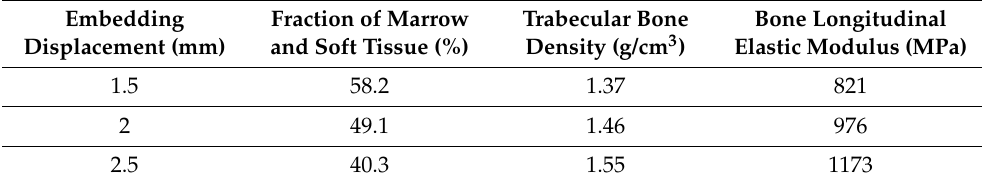
Table 3. Values of marrow and soft tissue fractions during embedding in the area of interest in the bone specimen and corresponding values of trabecular bone density and longitudinal elastic modulus of bone.